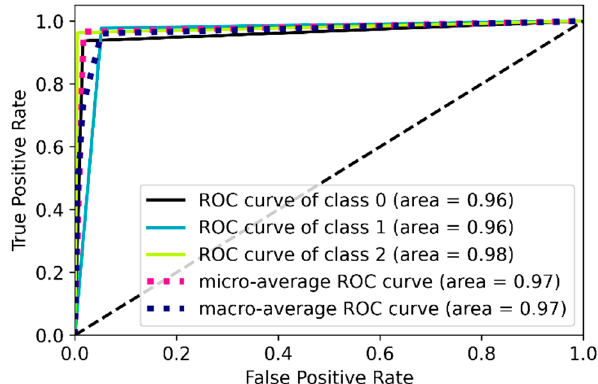
Figure 23. ROC curves and AUC values for three-class experiment by VGG16.